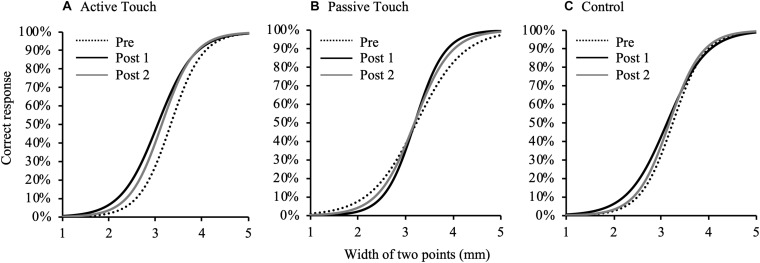
Changes in psychometric curves pre- and post- intervention under different conditions. Psychometric curves indicating plots of correct responses obtained after against width of two points of tactile stimulation and using different intervention methods. (A), Active Touch; (B), Passive Touch; and (C), Control. Dotted line, pre-intervention measurements; black line, Post 1 measurements; gray line, and Post 2 measurements.